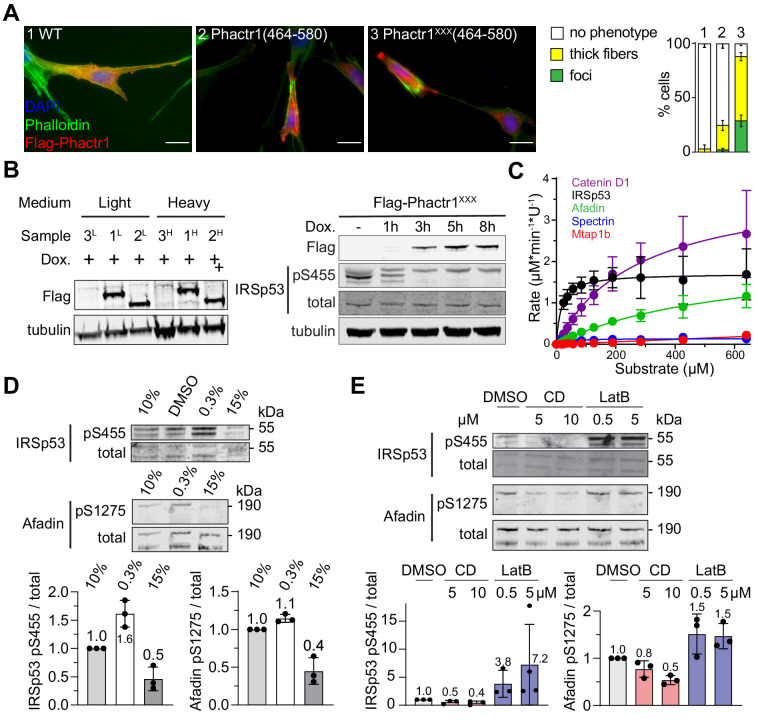
Substrates of the Phactr1/PP1 complex in NIH3T3 fibroblasts.(A) Expression of the Phactr1XXX(464-580), which constitutively binds PP1, induces cytoskeletal rearrangements in NIH3T3 fibroblasts. Scale bar, 20 µm. (B) Left, immunoblot analysis of Flag-Phactr1XXX and Flag-Phactr1XXXΔC expression in NIH3T3 cell lines cultured under SILAC labelling conditions. Detection was with Flag antibody. Right, dephosphorylation of endogenous IRSp53 pS455 upon expression of Flag-Phactr1XXX, detected with anti-IRSp53 p455 antibody. For protein structures, see Figure 3A. (C). Phactr1/PP1 phosphatase activity assay data for selected substrates from Figure 3D (data are ± SD, n = 3). (D, E) Immunoblot analysis of IRSp53 pS455 and afadin pS1275 in NIH3T3 cells upon overnight serum starvation and 30' serum stimulation (D), or 30' treatment with the actin-binding drugs cytochalasin D (CD) or latrunculin B (LB). Quantitation below (data are ± SD, n = 3). See also Supplementary file 1.